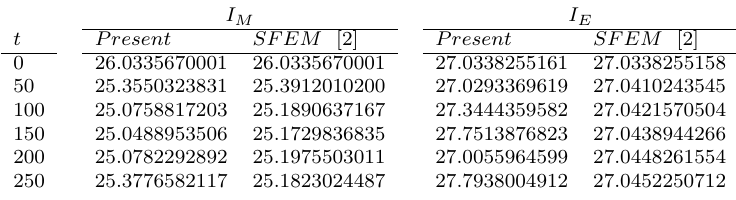
Comparison of conserved quantities for the interaction of three solitary waves with a = b = c = 1, d = 0 . 5, h = ∆t = 0 . 1, v 1 = 0 . 3, v 2 = 0 . 5, v 3 = 0 . 8, x 1 = − 70, x 2 = − 40 and x 3 = −